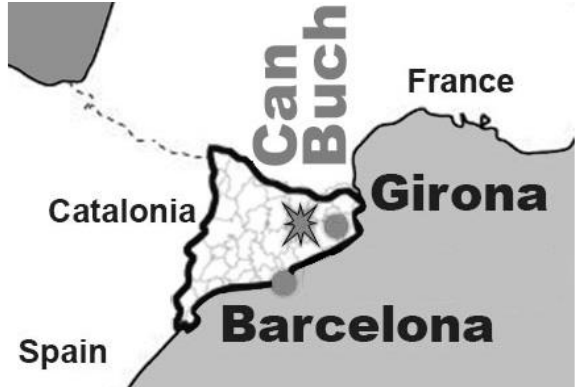
Figure 1. Can Buch location near Girona city.